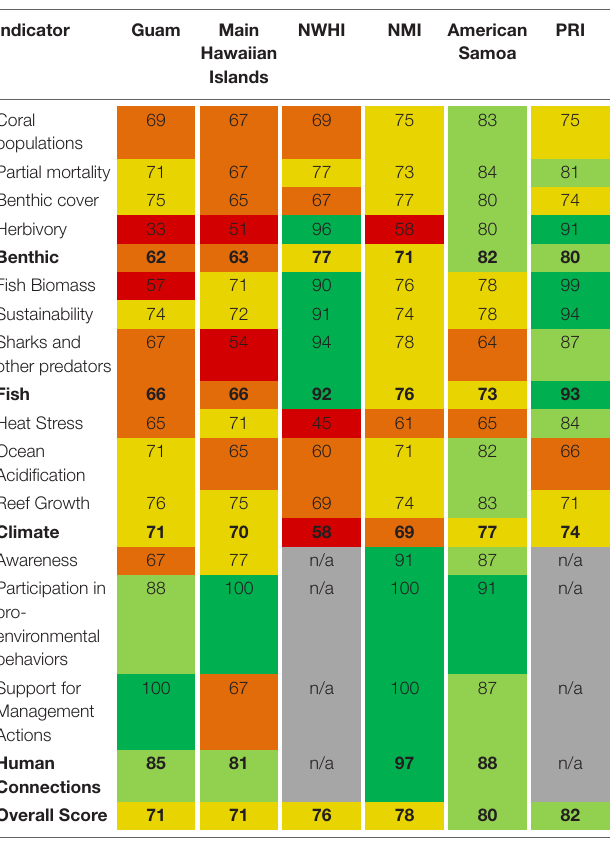
TABLE 9 | Scoring results for all six Pacific jurisdictions for all indicators in all four themes.